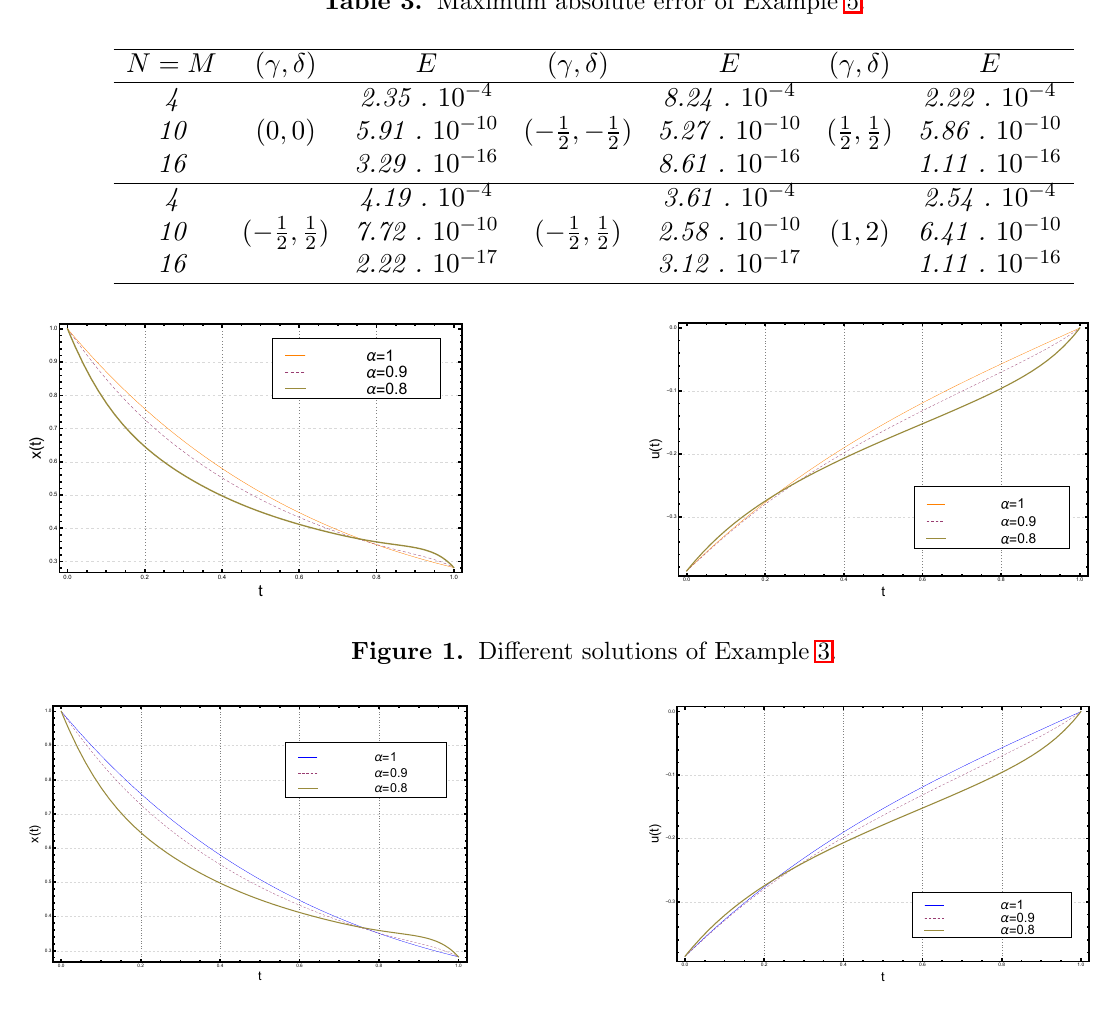
Figure 2. Different solutions of Example